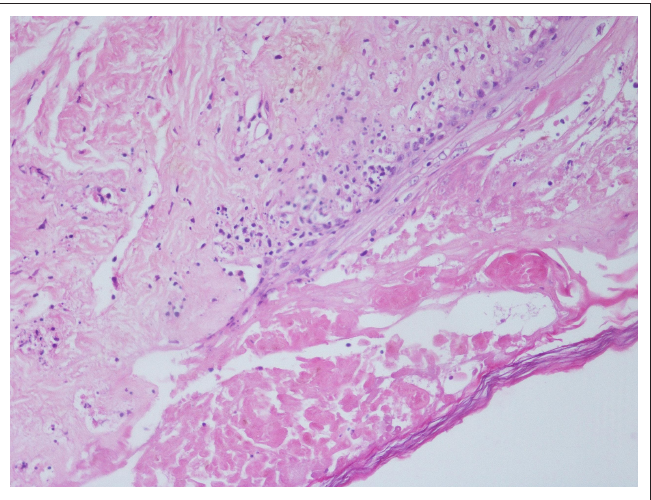
Figure 1. The presence of necrosis in other layers of the epidermis under the keratin layer on the surface is remarkable. Vacualization was observed in the basal cells. There is cell debris around the small vessel under the epidermis.